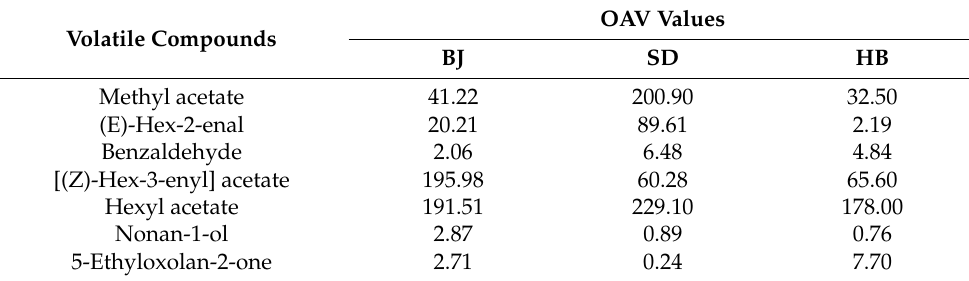
Table 3. The volatile compounds with OAVs > 1 in peach from three cultivation regions. OAV, odor activity value. BJ, SD, and HB represent Beijing, Shandong and Hebei provinces,